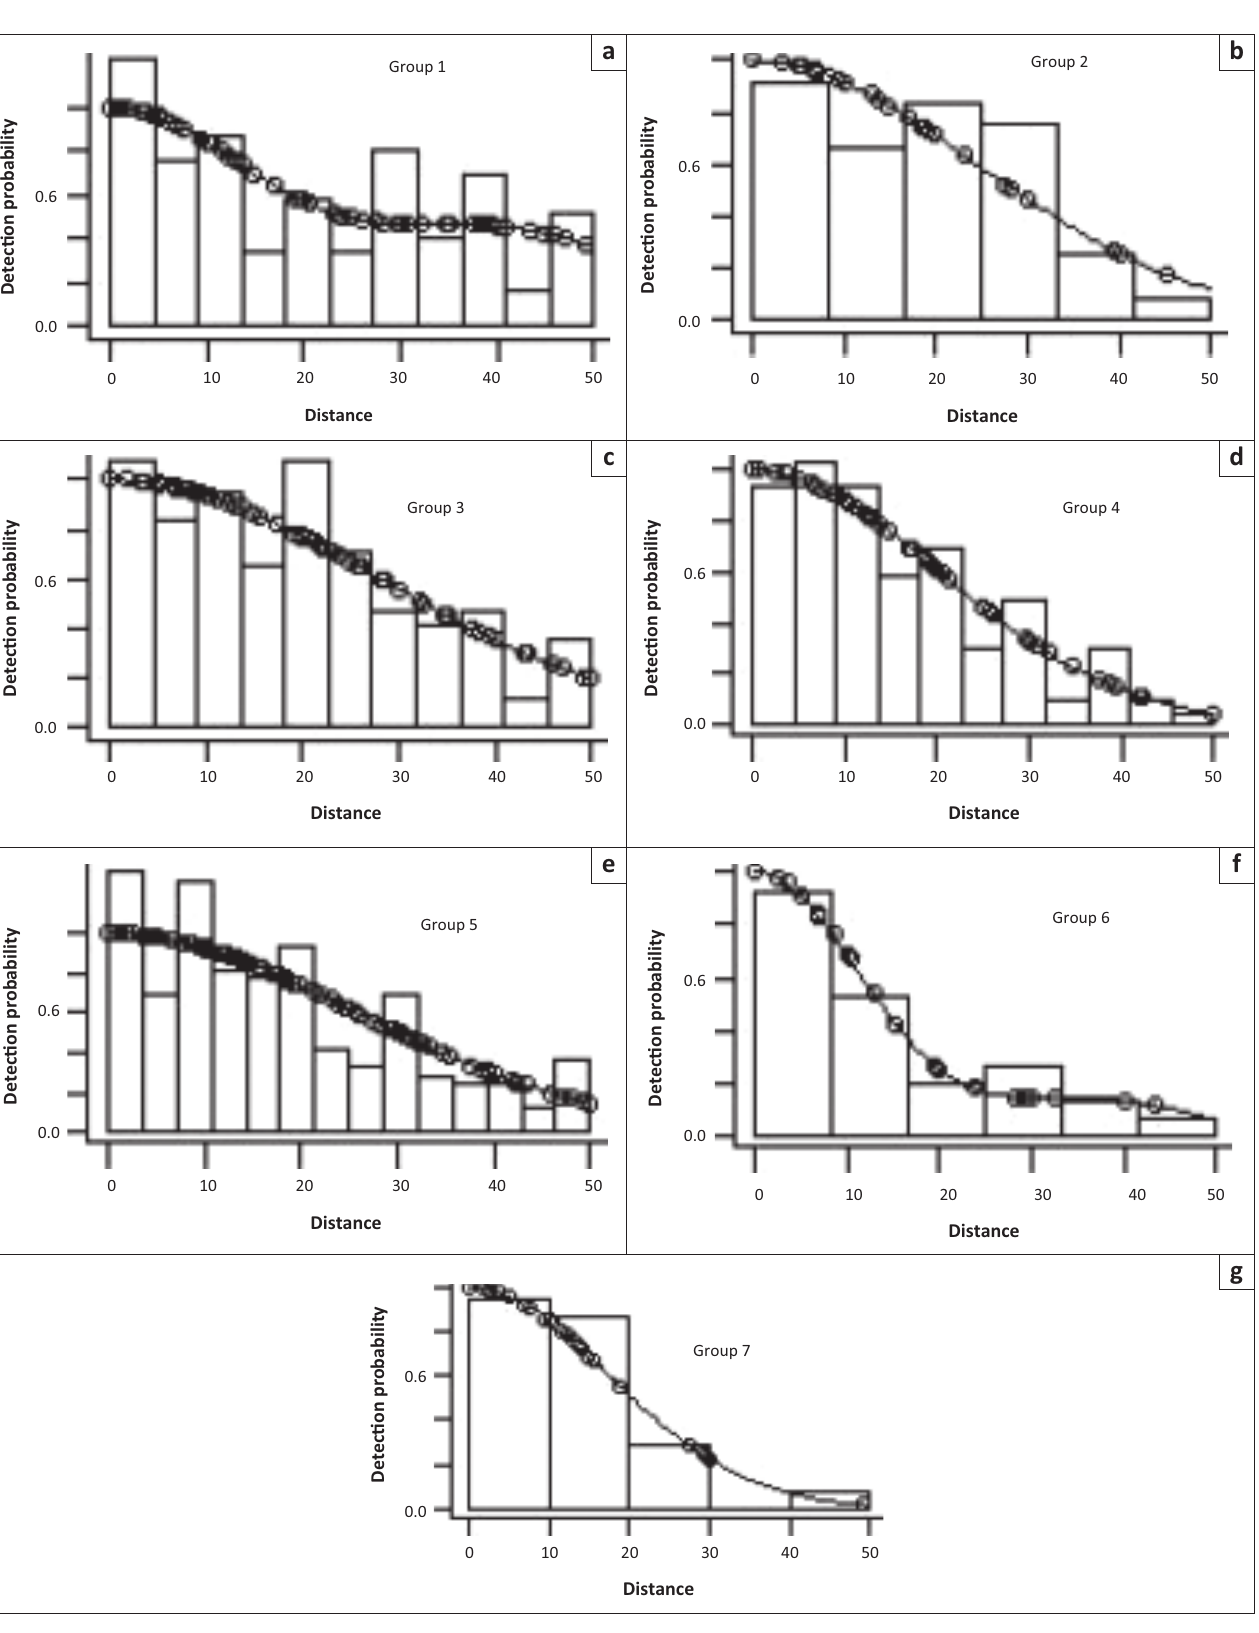
FIGURE 4-A1: Detectability curves for the seven surrogate bird species groups fit for protected areas. Surrogate group numbers are indicated in the top right of each figure. (a) Group 1 (large-bodied, ground nesters), (b) group 2 (small to medium bodied, mixed feeders, frugivores, hole nesters), (c) group 3 (small to medium bodied, granivores, mainly platform nesters), (d) group 4 (small to medium bodied, parasitic breeders or cup nesters, insectivores, nectarivores), (e) group 5 (small to medium bodied, mainly insectivores, mixed feeders, mixed breeders), (f) group 6 (small bodied, granivores, cup nesters) and (g) group 7 (medium bodied, insectivore/frugivores, mainly hole nesters). See Coetzee and Chown. (2016:2610-2622) for more